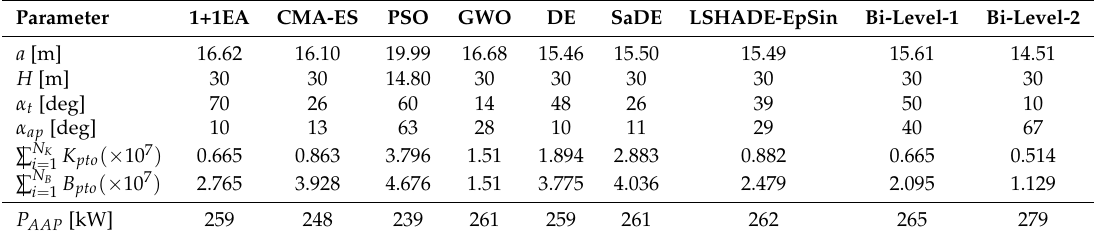
Table 4. Best-found design parameters in order to maximise the average annual absorbed power.